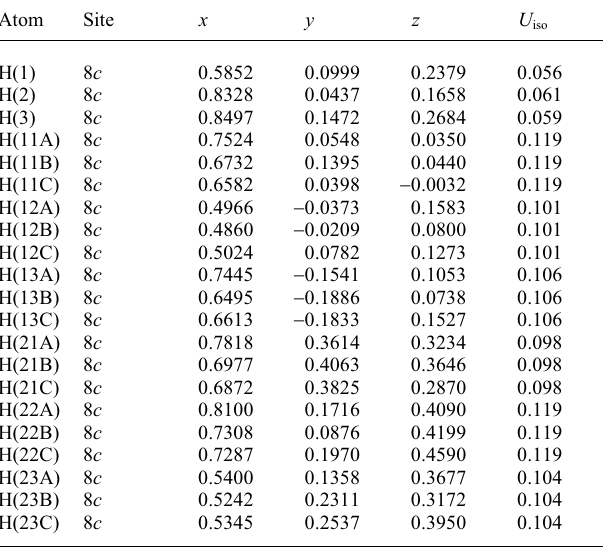
Table 2. Atomic coordinates and displacement parameters (in Å 2 )